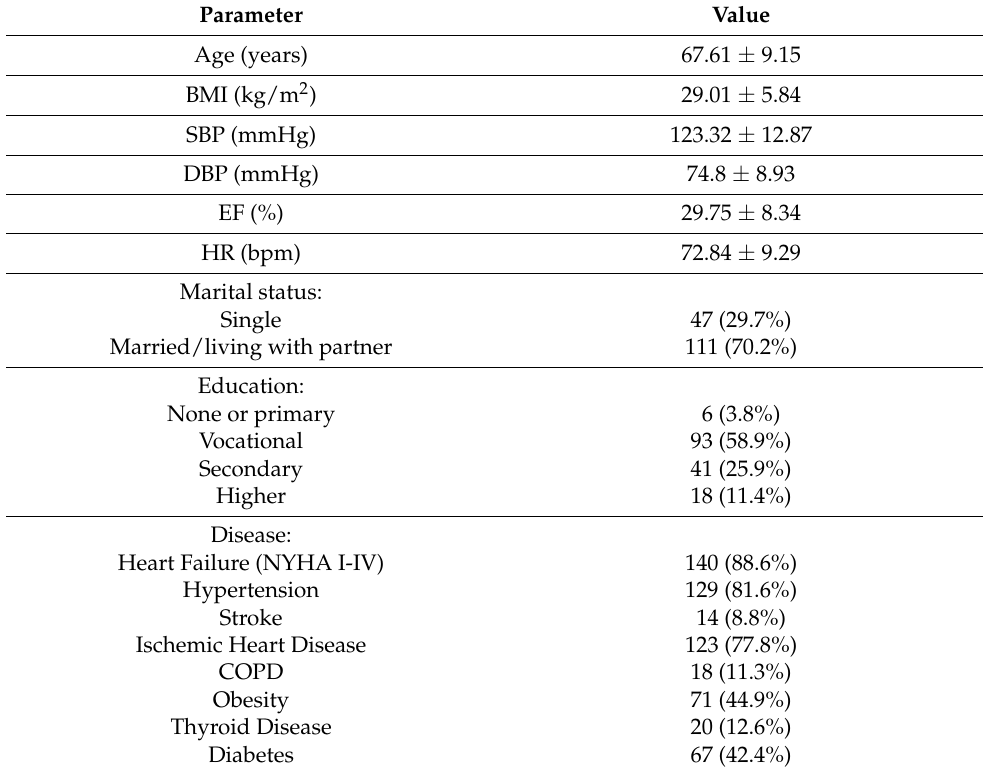
Table 1. Characteristics of the study